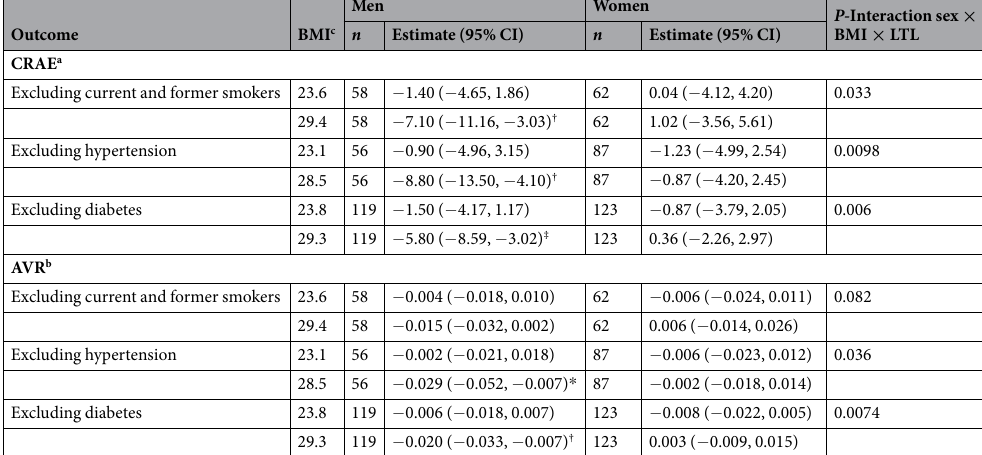
23.8 119 − 1.50 ( − 4.17, 1.17)